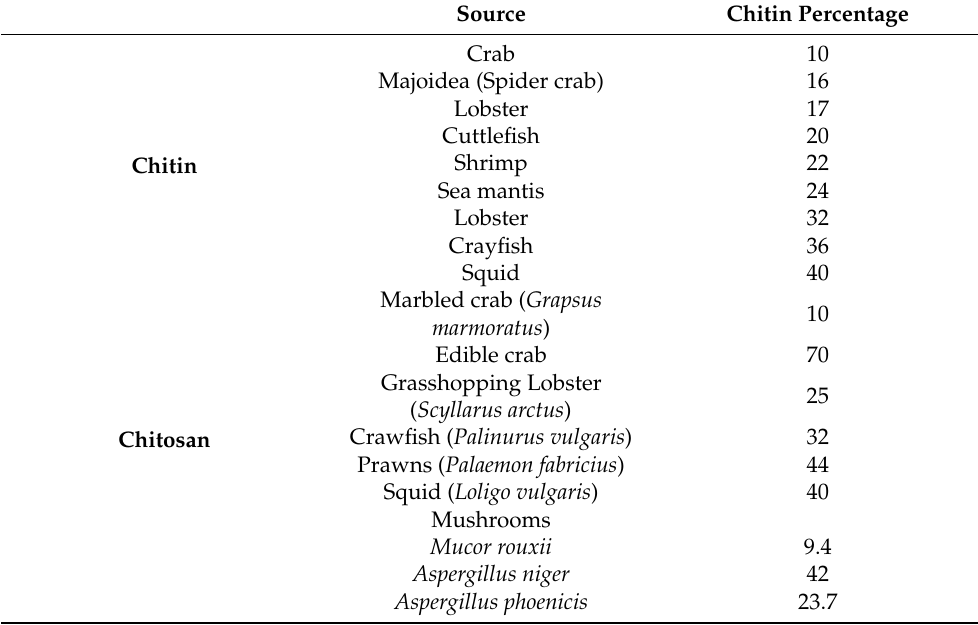
Table 1. Chitin and chitosan sources